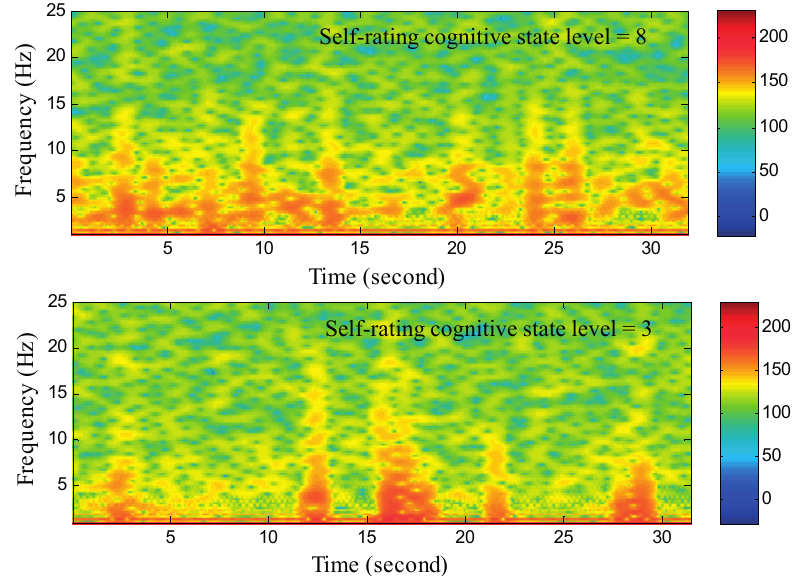
Figure 6. Time-frequency analysis of EEG signal corresponding to different self-rating cognitive state level.